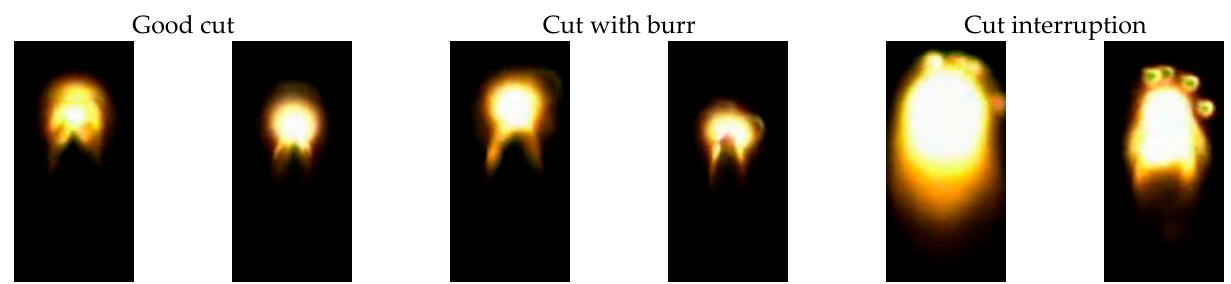
Figure 3. Examples of camera images of the three cut categories taken during laser cutting with the high speed camera.